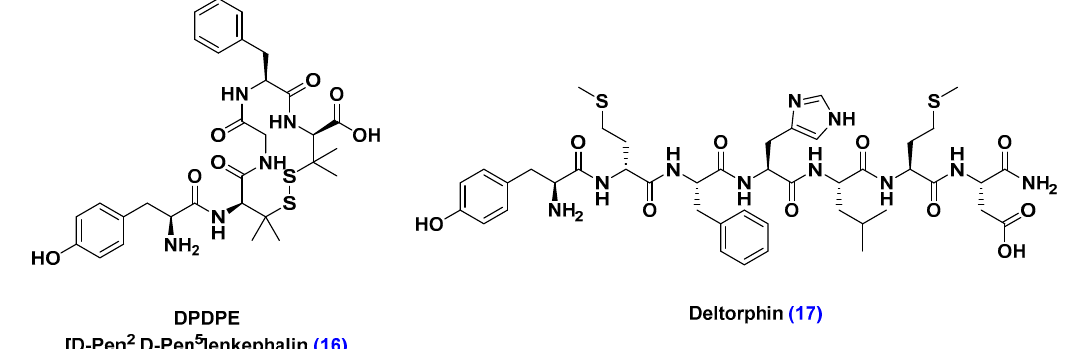
Figure 13. Structure of oligopeptides transported by organic anion transporting polypeptide carriers (OTAPs). Identification of DPDPE and deltorphin as OTAPs substrates can inspire the design of neurotherapeutic material or OTAPs-targeting ligands that mimic their structure. Receptor-Mediated Transcytosis (RMT)